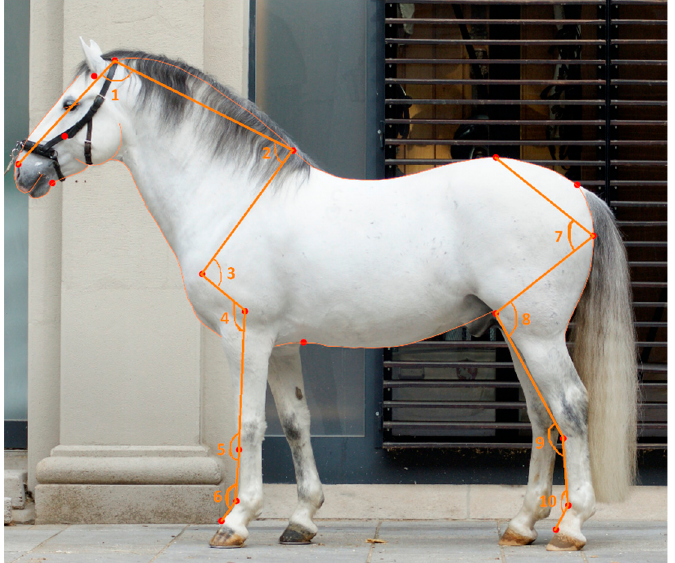
Figure 1. Horse shape space model of a Lipizzan horse photograph, including the following joint angles: (1) poll, (2) neck–shoulder blade, (3) shoulder joint, (4) elbow joint, (5) carpal joint, (6) fetlock joint of the forelimb, (7) hip joint, (8) stifle joint, (9) hock joint, and (10) fetlock joint of the hind limb.